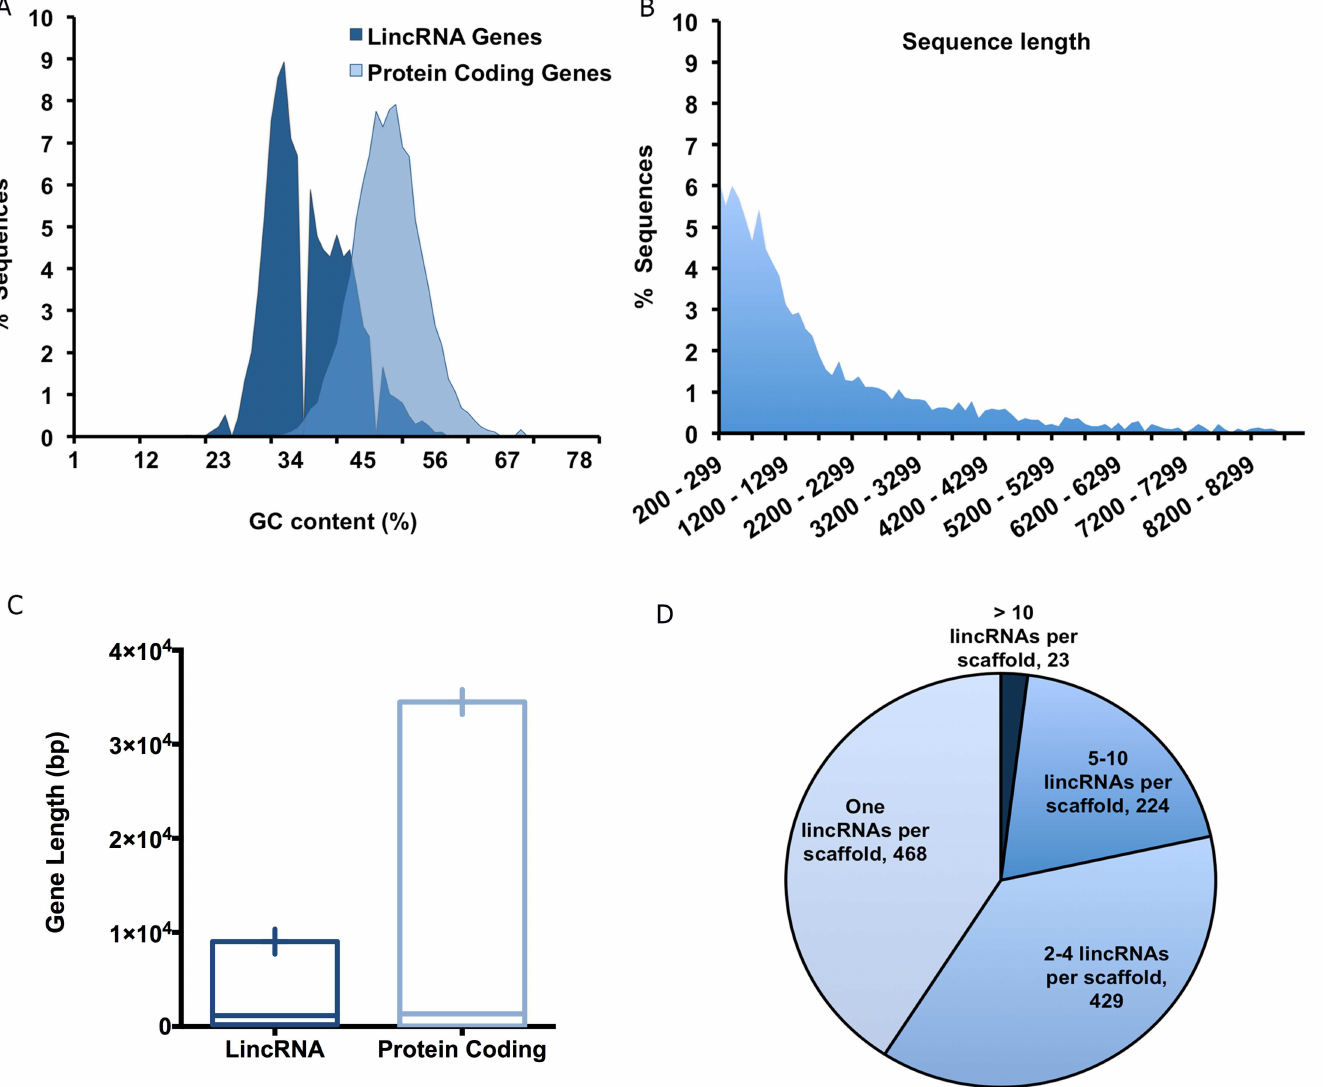
Fig 2. Aedes aegypti lincRNA characterization. A) Comparison of the GC content in protein-coding genes and the putative lincRNA genes. B) Sequence length distribution of Ae . aegypti lincRNA candidates. C) Comparison of gene length in protein-coding genes and putative lincRNA genes. D) lincRNAdistributionamong different Ae . aegypti genomescaffolds. The majority of scaffolds (~77%) only contain 1–4 lincRNAs, while only 23 Ae . aegypti genomescaffolds contain more than 10 lincRNAs